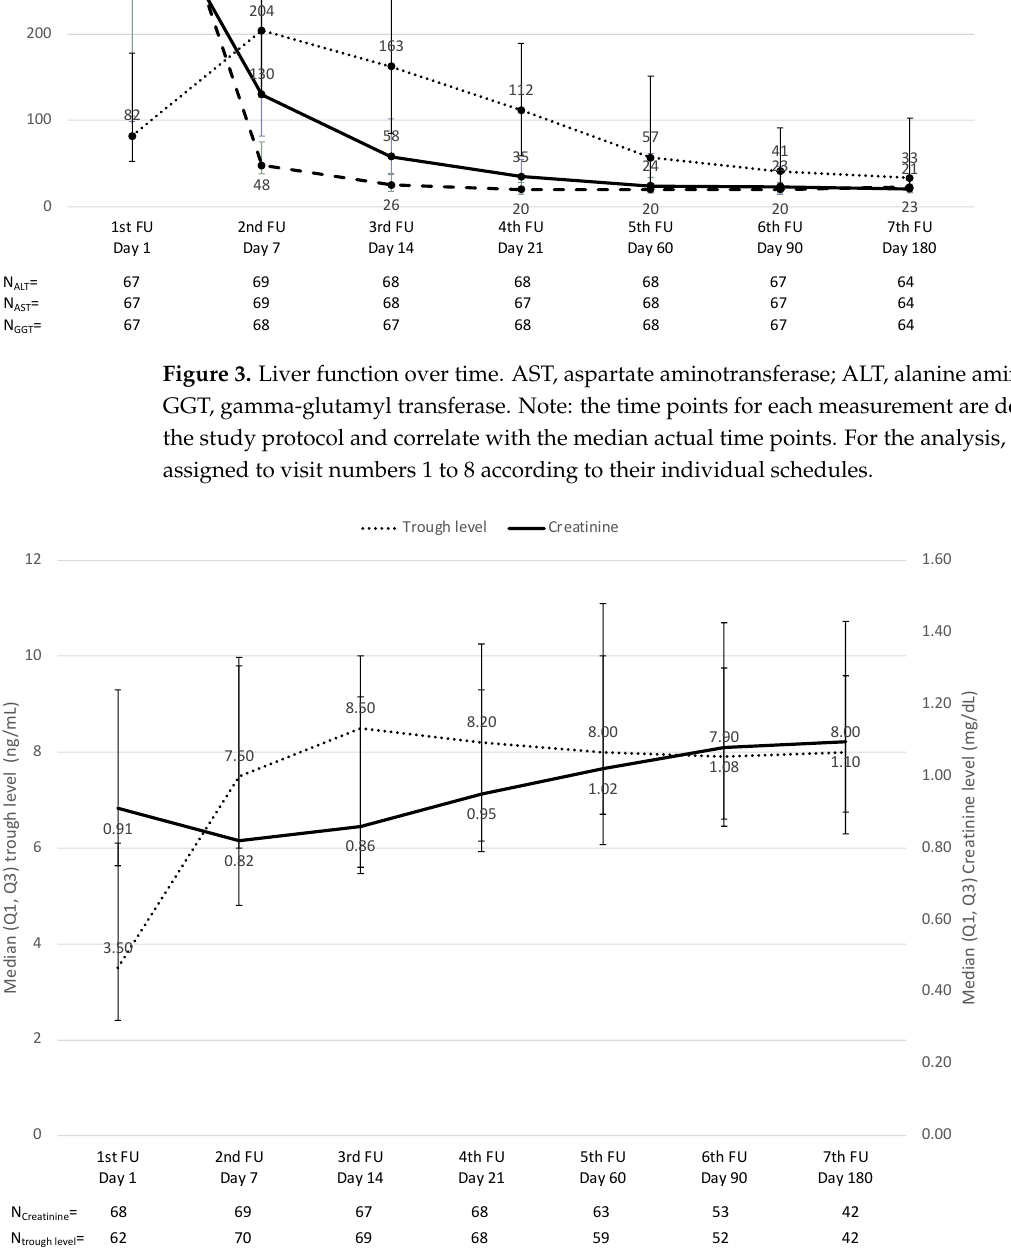
Figure 4. Serum creatinine and trough levels over time. Note: the time points for each measurement are depicted as per the study protocol and correlate with the median actual time points. For the analysis, patients were assigned to visit numbers 1 to 8 according to their individual schedules.